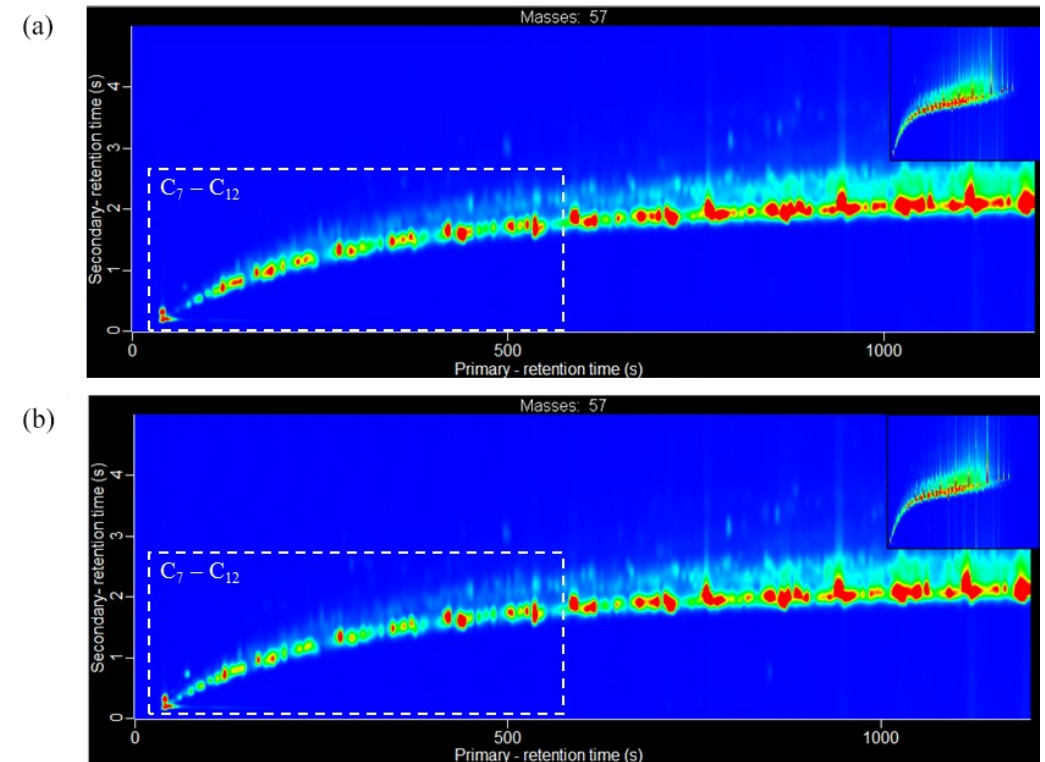
Figure 8. Extracted ion chromatogram of m/z 57 (dominate aliphatic fragment ion) for the liquid diesel fuel samples analysed using GC × GC-TOFMS. (a) Fuel batch A (see Sect. 3.1.1 for further information). (b) Fuel batch B. Chromatogram axes: x is the primary column, first dimension separation (boiling point, increasing from left-to-right) and y is the secondary column, second dimension separation (polarity, increasing from bottom-to-top). Colour scale represents peak intensity, increasing from blue to red. Chromatograms have been normalised to allow direct comparison of peak intensity between chromatograms. Dashed box highlights an approximate carbon number range of C 7 to C 12 , determined from the NIST library identification of individual